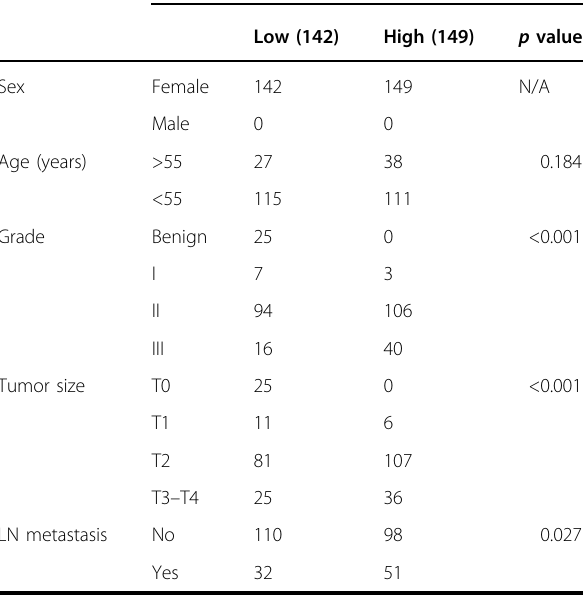
Table 1 Correlation between p97 expression and clinicopathological features of breast cancer patients ( n =